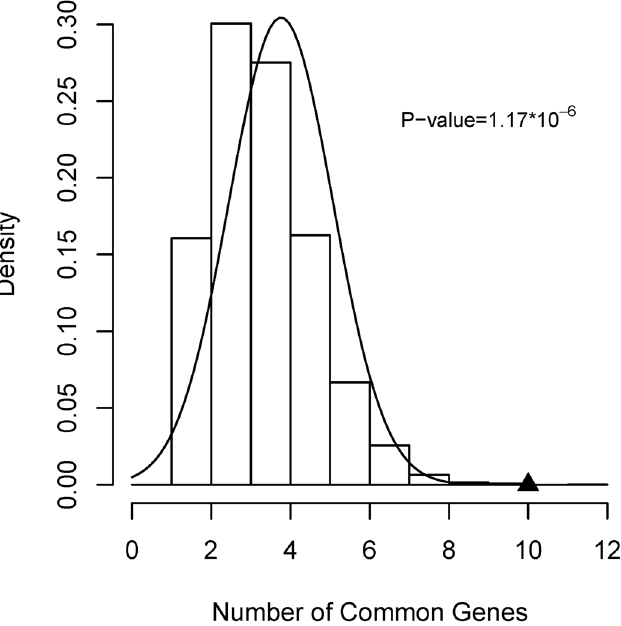
Fig 3. Probability density for obtaining common genes. The observed value is marked with a filled triangle.